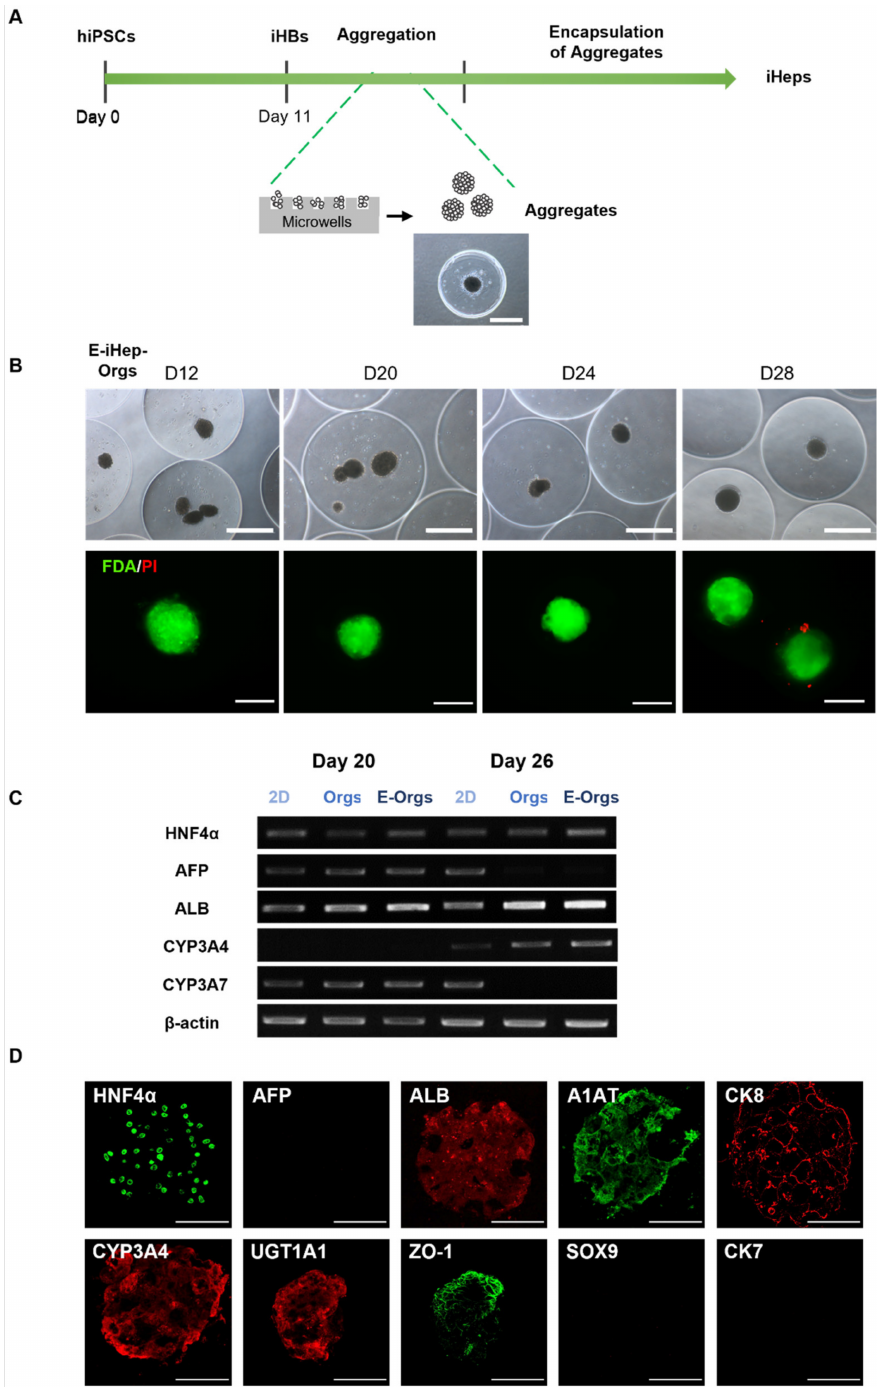
Figure 2. Production of iHeps from iHBs in encapsulated organoids (E-iHep-Orgs). ( A ) Experimental procedure showing the experimental course of differentiation of hiPSCs into functional iHeps. After the differentiation of iHBs from hiPSCs in a monolayer, suspended iHBs were allowed to self- aggregate in microwells and were then encapsulated in alginate beads for differentiation into iHeps (E-iHeps-Orgs). ( B ) Phase contrast microscopy images (scale bar: 500 µ m) and assessment of the viability of encapsulated aggregates throughout differentiation under epifluorescence microscopy. In green (fluorescein diacetate—FDA): viable cells. In red (propidium iodide—PI): dead cells (scale bar: 200 µ m). ( C ) RT-PCR analysis of HNF α , AFP, ALB, CYP3A4, CYP3A7 in 2D differentiated iHeps, in organoids (Orgs) and in encapsulated organoids (E-Orgs). ( D ) Immunofluorescence staining of E-iHep-Orgs at the final stage of differentiation (Day 28) (scale bar 150 µ